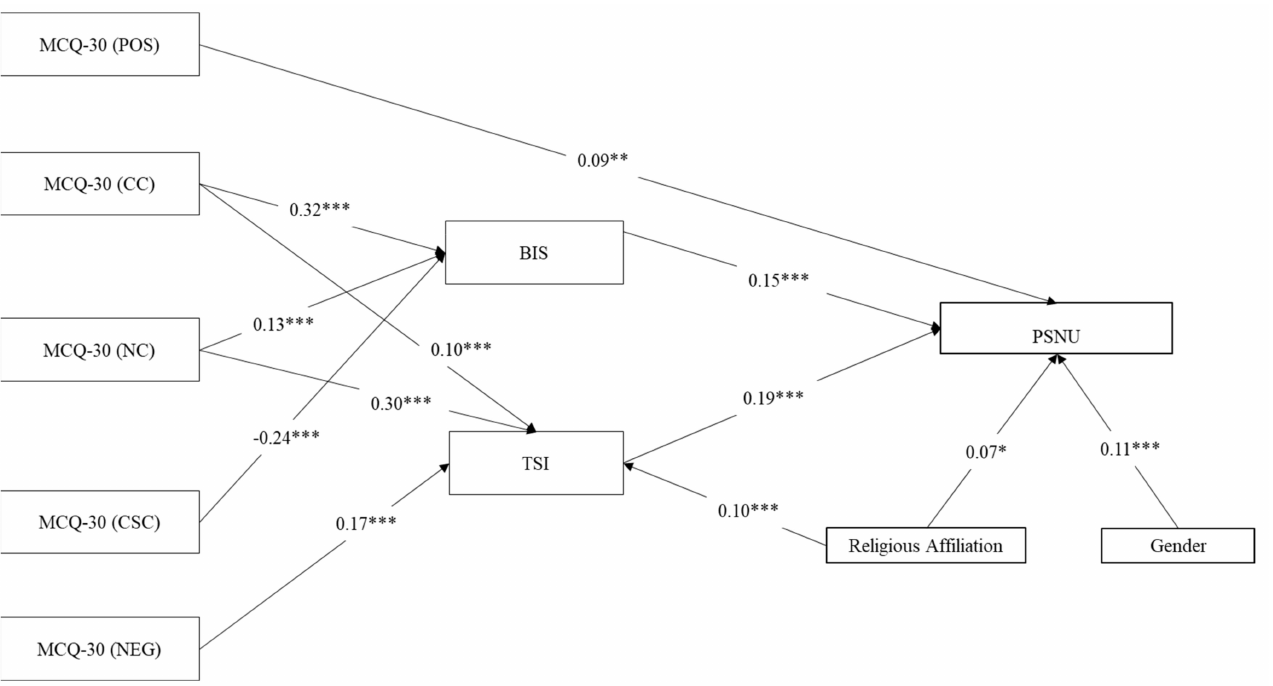
Figure 4. Results of the path analytical model with PSNU as outcome variable. Notes: * p < 0.05, ** p < 0.001, *** p < 0.001; n = 1004; Coefficients are standardized estimates; Religious Affiliation = (1 = Low, 2 = High); Gender: 1 = M, 2 = F; MCQ-30 (POS) = Metacognitions Questionnaire-30 (Positive Beliefs about Worry); MCQ-30 (NEG) = Metacognitions Questionnaire-30 (Negative Beliefs about Thoughts concerning Uncontrollability and Danger); MCQ-30 (CC) = Metacogni- tions Questionnaire-30 (Cognitive Confidence); MCQ-30 (NC) = Metacognitions Questionnaire-30 (Beliefs about the Need to Control Thoughts); MCQ-30 (CSC) = Metacognitions Questionnaire-30 (Cognitive Self-Consciousness); BIS = Barret Impulsivity Scale; TSI = Thought Suppression Inventory; PSNU = Problematic Social Networks